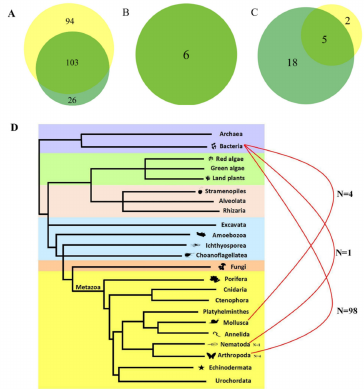
Figure 5. HT events of Sailor . ( A ) The two organelle ribosomal proteins (L3 and L4) exhibited prokaryotic to eukaryotic HT events. The yellow color represents the HT characteristic of the organelle ribosomal protein L3, the dark-green color represents HT common to the organelle ribosomal proteins L3 and L4, and the light-green color represents the HT characteristic of the organelle ribosomal protein L4. ( B ) The two cytoplasmic ribosomal proteins (L3 and L4) exhibited HT events in prokaryotic species. The dark-green color represents HT common to the cytoplasmic ribosomal proteins L3 and L4. ( C ) The two cytoplasmic ribosomal proteins (L3 and L4) exhibited HT events in eukaryotic species. The yellow color represents the HT characteristic of the cytoplasm ribosomal protein L3, the dark-green color represents HT common to the cytoplasmic ribosomal proteins L3 and L4, and the light-green color represents the HT characteristic of the cytoplasm ribosomal protein L4. ( D ) HT based on the pairwise genetic distance comparisons of two proteins. The numbers next to the animal silhouettes represent species pairs supporting HT events in the same phylum, and the numbers behind the curve represent species pairs supporting HT events from prokaryotic to eukaryotic